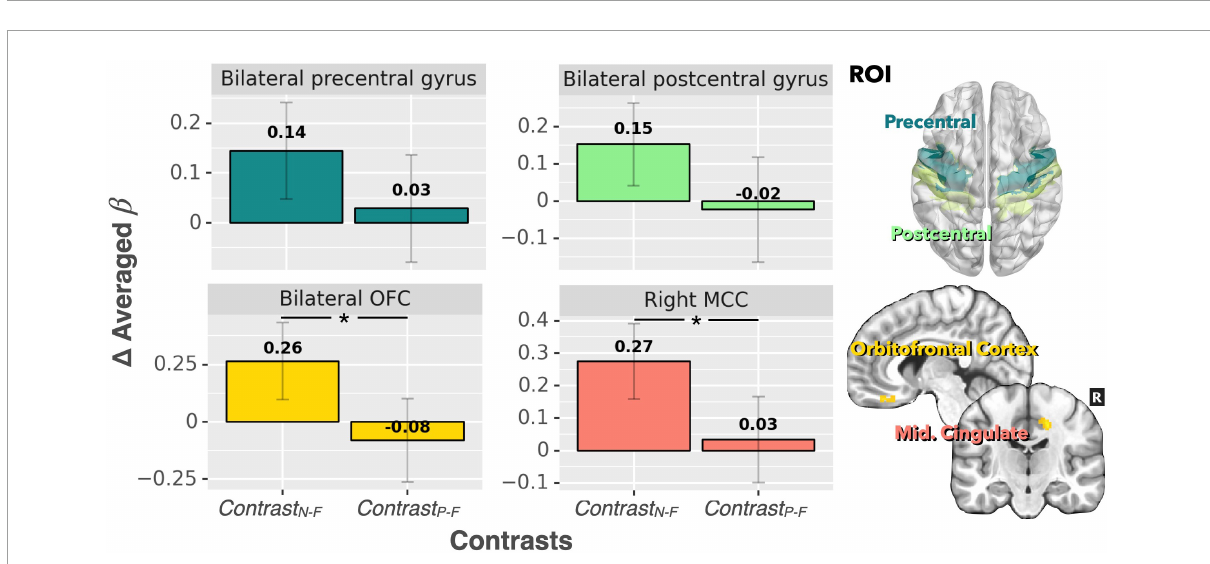
FIGURE3 Beta value (averaged over the whole ROIs) comparisons between Contrast N − F and Contrast P − F for bilateral precentral gyrus, postcentral gyrus, bilateral OFC, and right MCC. There was a significant difference in neural activation between the two contrasts for both the MCC and OFC. A trend of decreased activation in Contrast P − F (compared to Contrast N − F ) was observed for the precentral gyrus and postcentral gyrus ( p < 0.1). * p <